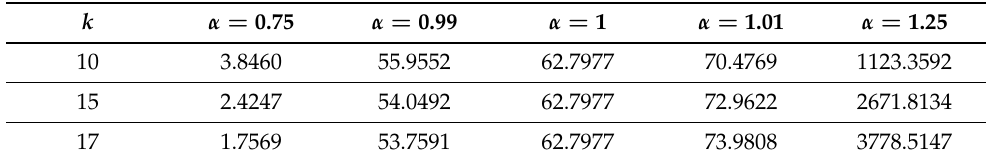
Table 2. Estimations of the C constant in the condition for Hölder continuity with exponent α for approximations of the limit function with k levels of subdivision for initial data coming from 20 point values of the function f ( x ) at the grid X 2 of non-equally spaced abscissas.